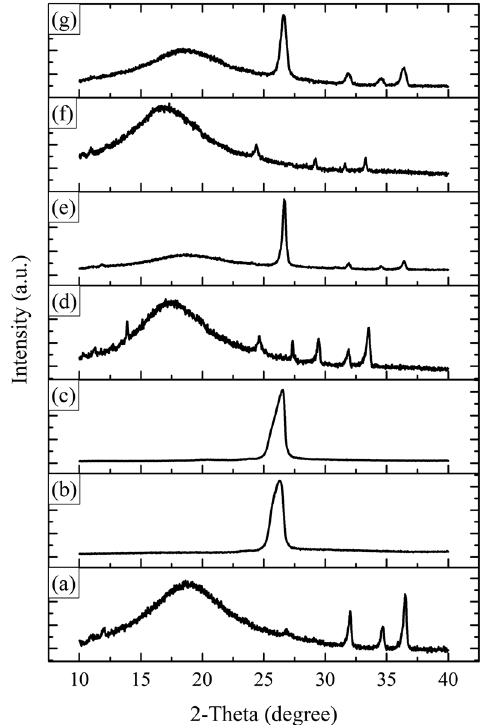
Figure 2: XRD di ff raction of ( a ) NRL, ( b ) GNP – SDS, ( c ) GNP - pristine, ( d ) NRL/GNP - pristine - 1 phr, ( e ) NRL/GNP - pristine - 7 phr, ( f ) NRL/ GNP – SDS - 1 phr, and ( g ) NRL/GNP – SDS - 7 phr.